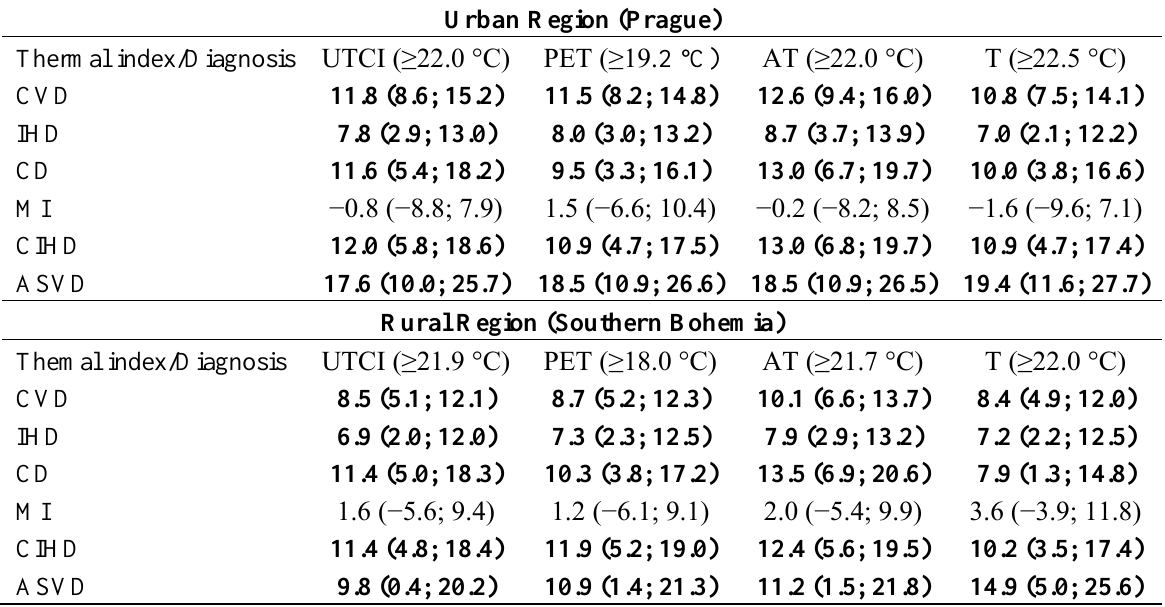
Table 2. Relative excess cardiovascular mortality with 95% CI (in parentheses) on warm days, defined as days with average (equivalent) temperature above the 90% quantile of the empirical distribution (≥°C), in Prague and southern Bohemia over 1994–2009. Values significantly different from zero are highlighted in bold.